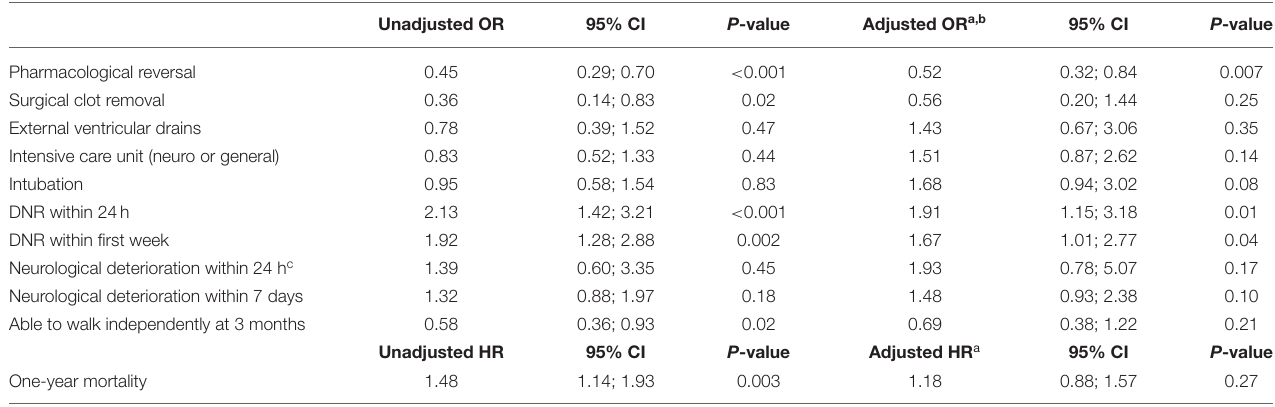
TABLE 2 | Interventions and outcomes in 226 men and 175 women with OAC-related